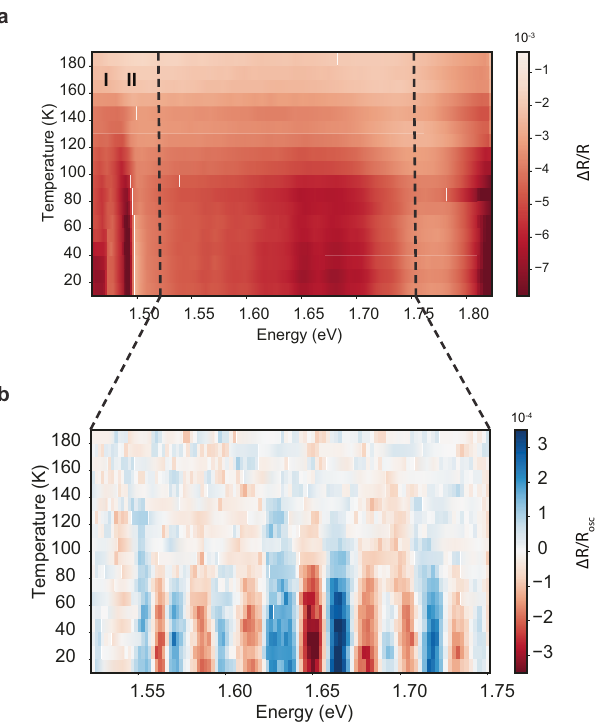
Fig. 2 Temperature dependence of phonon replicas. a Temperature dependence of the spin – orbit-entangled excitons and spectral oscillations. Exciton states become visible below the Néel temperature, as reported previously. Phonon-dressed d – d excitations also follow the Néel order. b Enlarged view of the d – d transition region. The background is subtracted using a fi fth-order polynomial fi t.